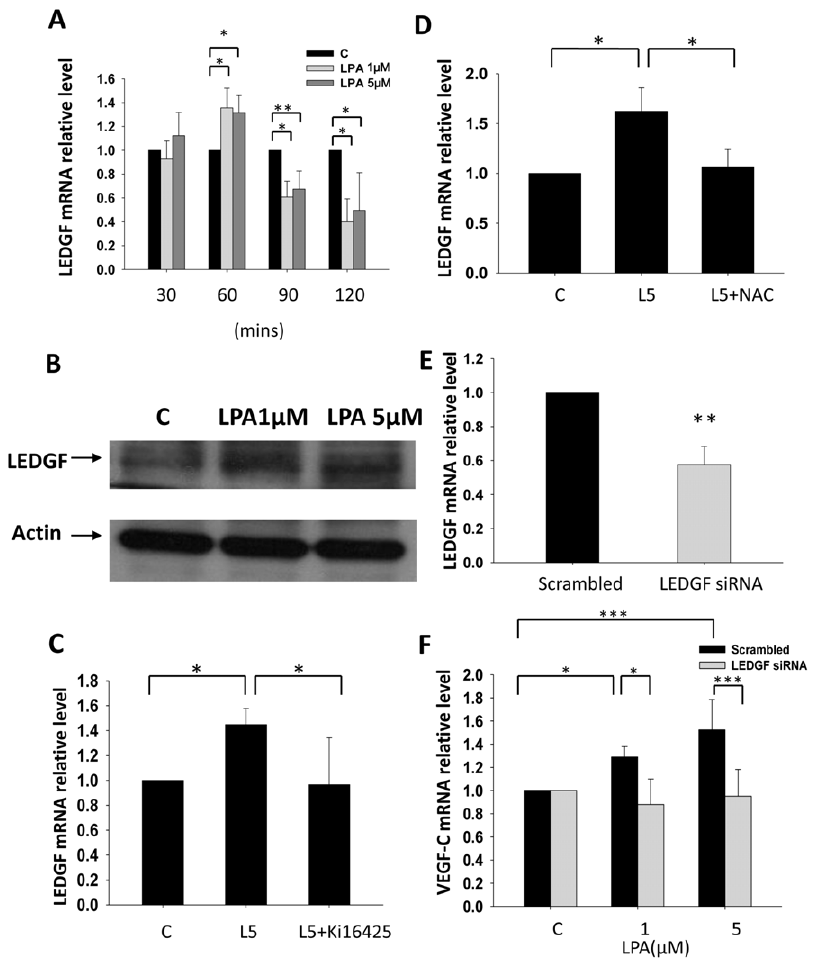
Figure 4. The role of LEDGF in LPA induced VEGF-C expression. PC-3 cells were treated with LPA and mRNA (A) and protein (B) expression levels of LEDGF were determined. LEDGF proteinm was collected after 2 hr LPA treatment. Pretreatment with 10 m M Ki16425 and 10 mM NAC for 1 h suppressed the effects of LPA (L5: 5 m M LPA) on LEDGF expression (C and D). LEDGF siRNA was transfected into PC-3 cells (E) and suppressed LPA’s effects on VEGF-C expression (F). mRNA was reverse-transcribed and analyzed by a real-time PCR. The relative levels of LEDGF and VEGF-C normalized to GAPDH are shown. * Statistically different compared to vehicle-incubated samples treated with LPA (* p , 0.05; ** p , 0.01; *** p , 0.001).